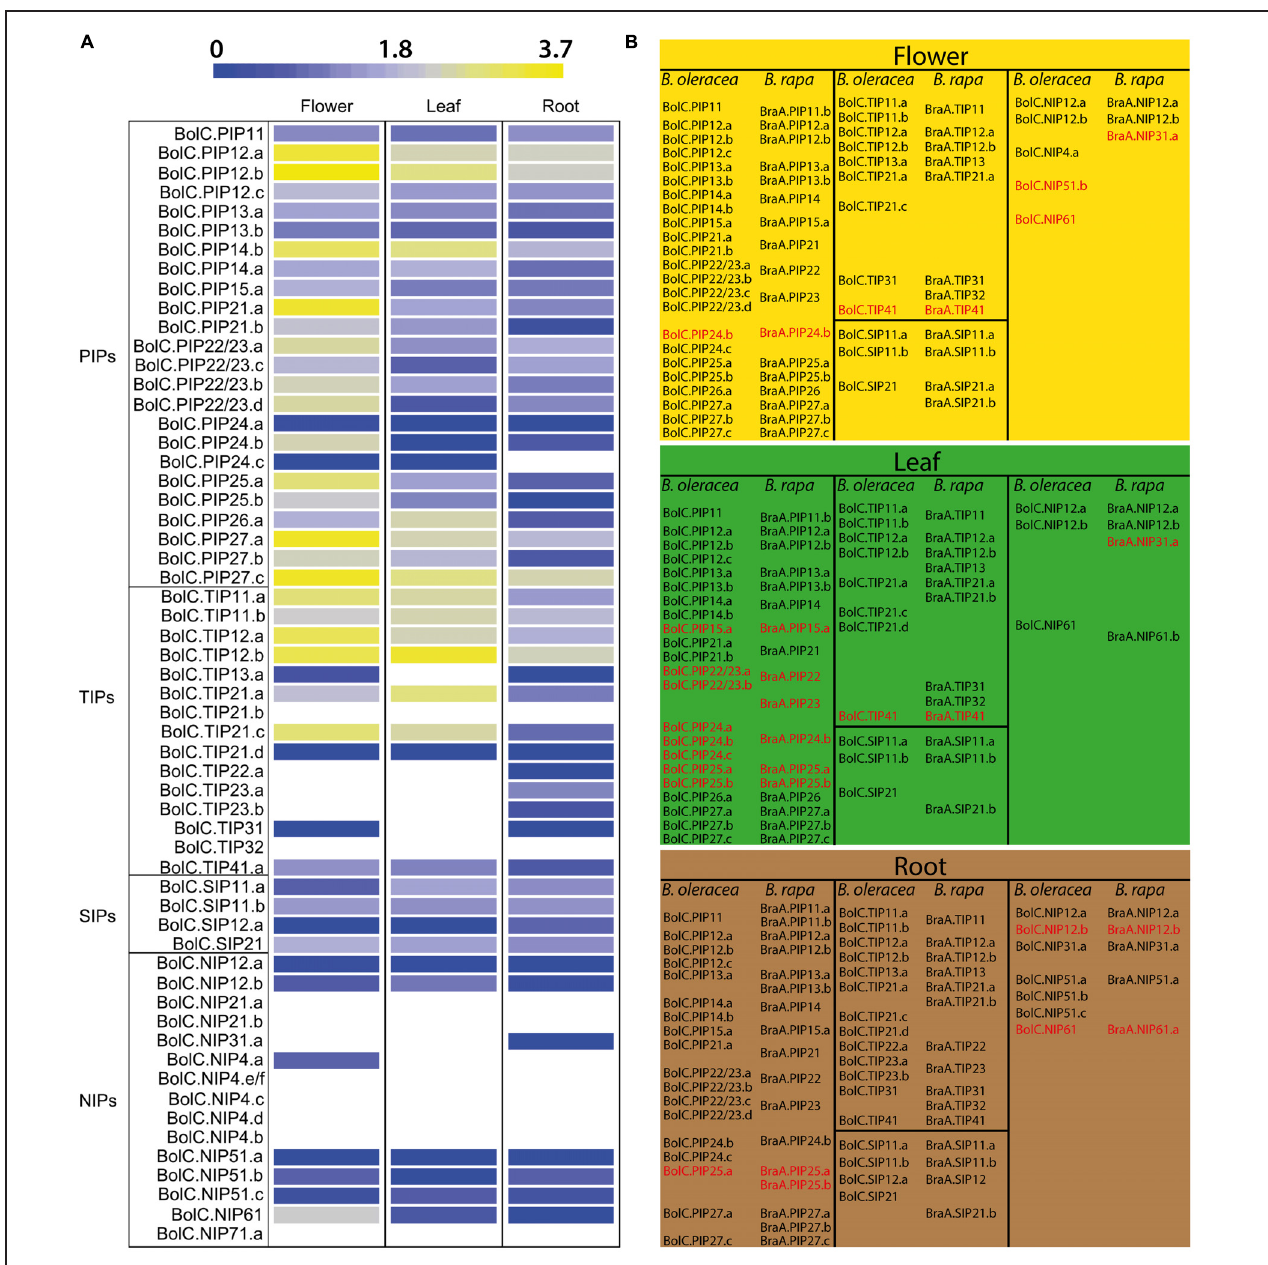
FIGURE 9 | Expression analyses of B. oleracea AQP genes. (A) Visualization of B. oleracea RNA-seq data of flower (GSM1052959), leaf (GSM1052960), and root (GSM1052961) organs. Expression values are given after logarithmic transformation of RPKM (reads per kilobase of exon model per million mapped reads). (B) Assignment of B.